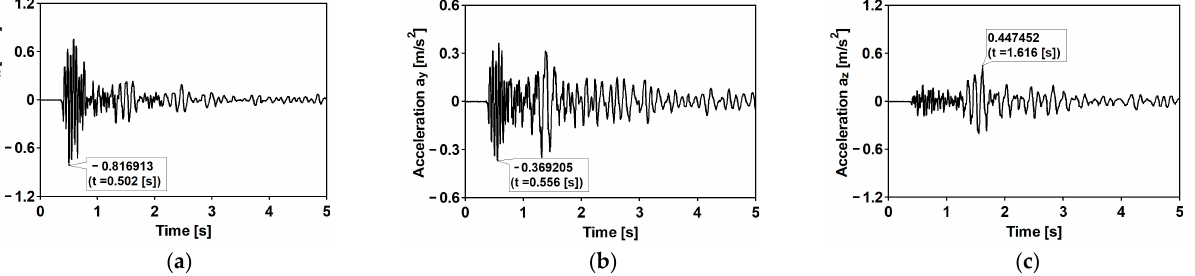
Figure 7. The time history of the registered ground acceleration for the first mining-induced shock: ( a ) horizontal direction WE; ( b ) horizontal direction NS; ( c ) vertical direction Z.